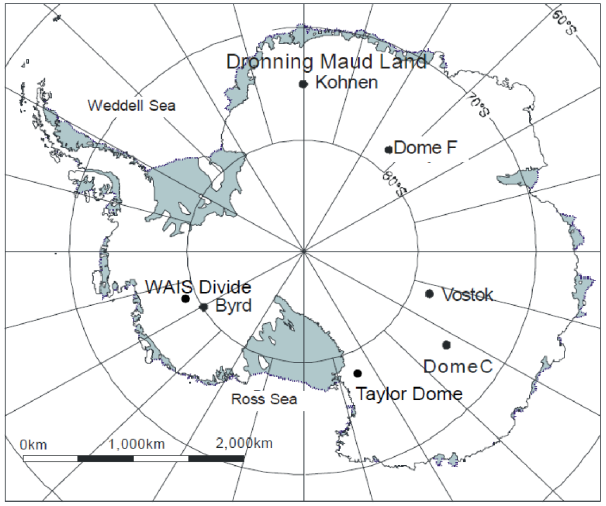
Figure 1. Map of Antarctica indicating Dome C and other important deep-drilling sites in